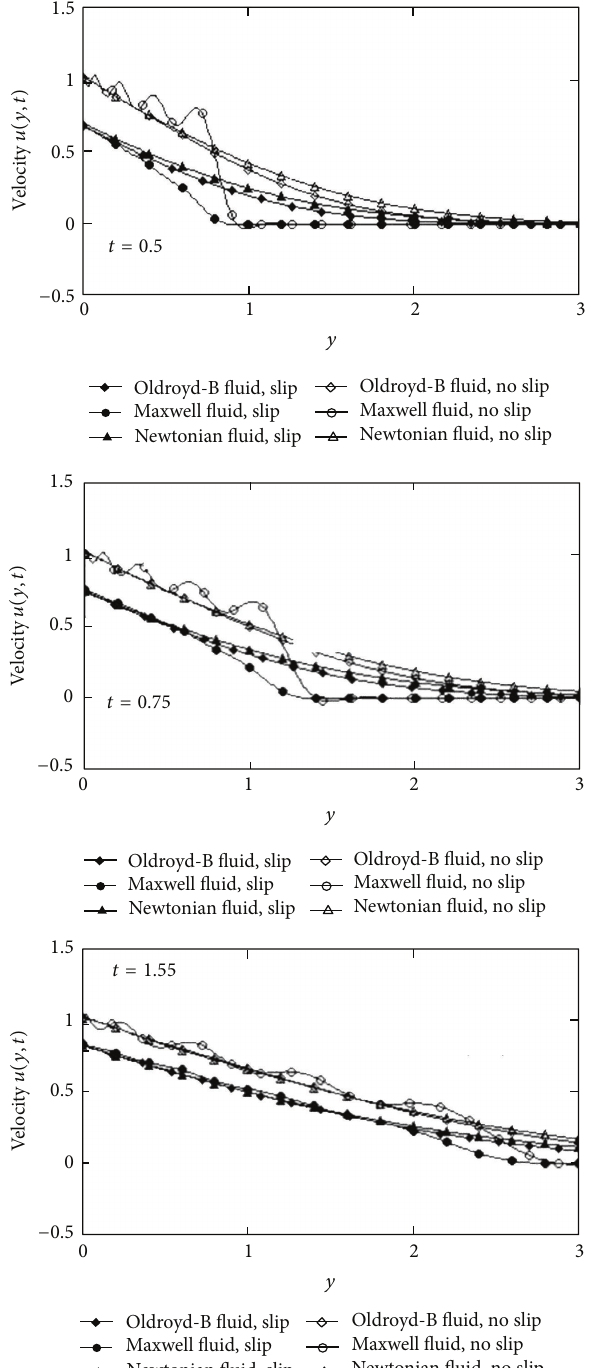
Figure 3: Comparison between velocity profiles of three fluid models with slip condition with 𝛽 = 0.55 and no-slip condition, for Re = 0.65, = 0.35 𝜆 = 0.55 , and 𝜆 𝑟